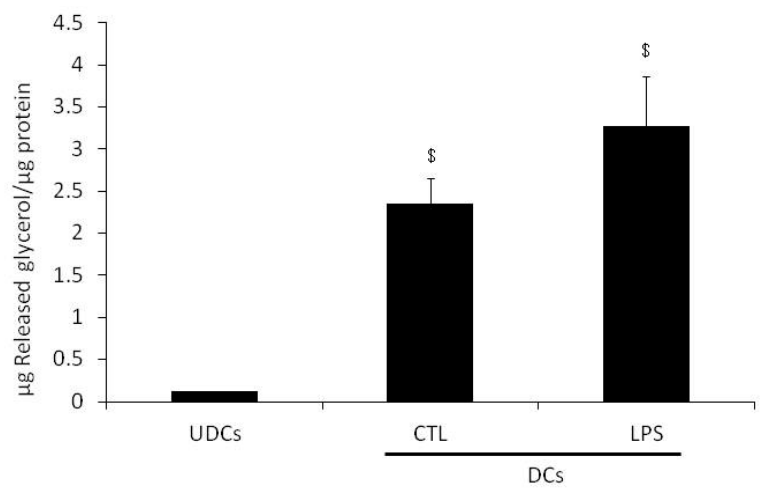
Figure 1. Glycerol release from undifferentiated 3T3-L1 cells (UDCs) and from 3T3-L1 cells differentiated into adipocytes (DCs), untreated (CTL) or treated with lipopolysaccharide (LPS). DCs were treated for 4 h with water (CTL) or 1 µ g LPS/mL (LPS). Glycerol release was determined in the culture media as described in Materials and Methods. The results are expressed as µ g of released glycerol per µ g of protein and are the mean ± S.E.M. of 3 independent experiments performed in triplicate. Data were analyzed using repeated measures One-way ANOVA and Bonferroni post-hoc t -test, $ p < 0.05 vs. UDCs.